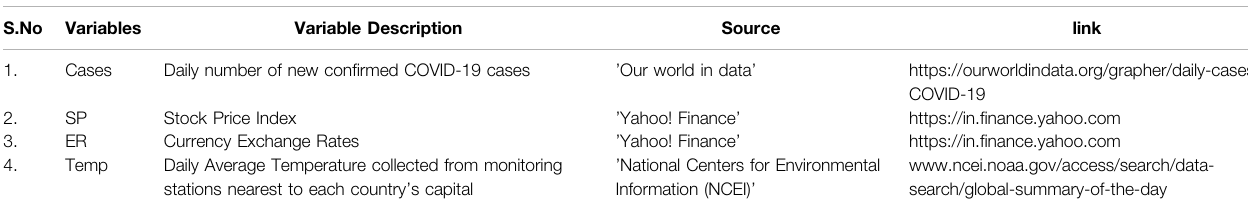
TABLE 3 | List of variables and source of data covered in the